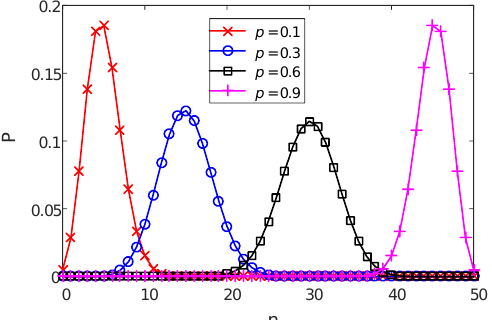
Figure 4. Binomial distribution probability.